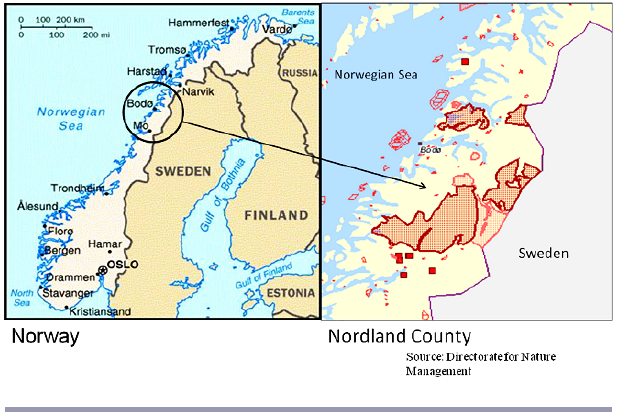
Fig. 1 . Protected areas in Central Nordland,